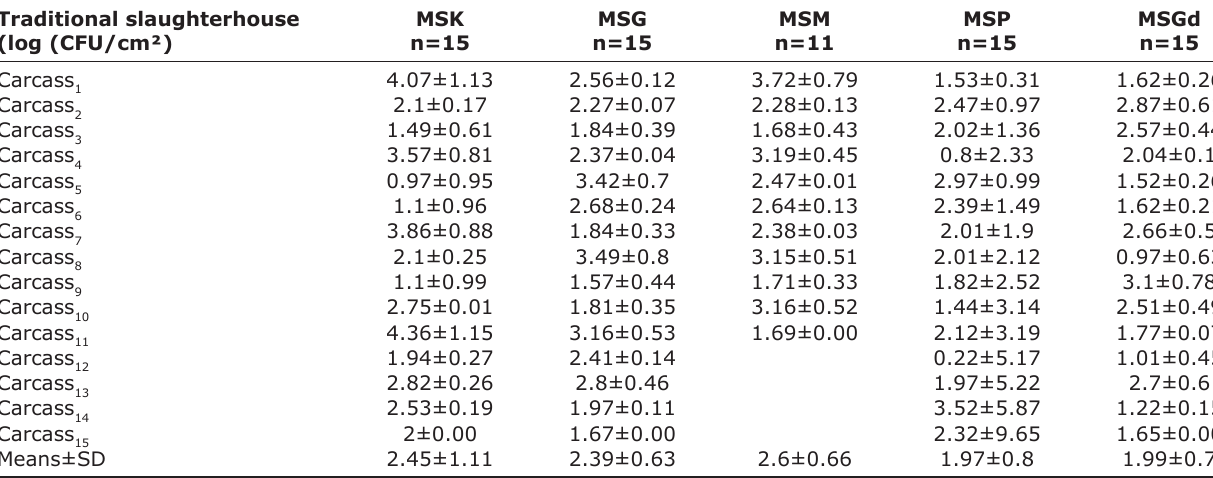
Table-1: Mean concentration of Staphylococcu s with positive coagulase in some slaughterhouses. Traditional slaughterhouse (log (CFU/cm²)